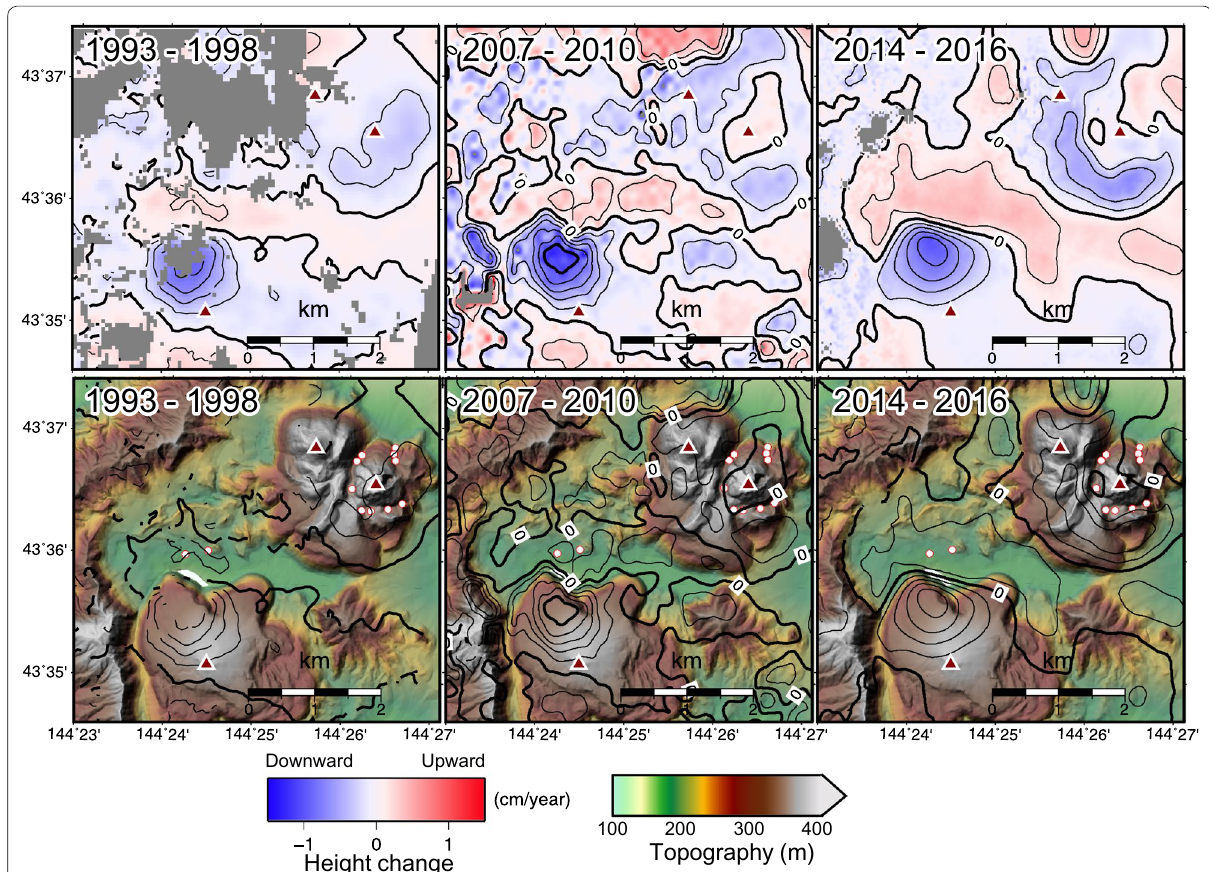
Fig. 8 Average yearly rate of height change. Contour interval is 0.2 cm. Left figures are calculated from InSAR pairs 1, 3, 5, 7, 8, 9, and 11, center figures from A1 and A2, and right figures from A3, A4, and A5. In the lower figures , the same contours are drawn on the topography as in the upper figures . The target area is shown inFig.